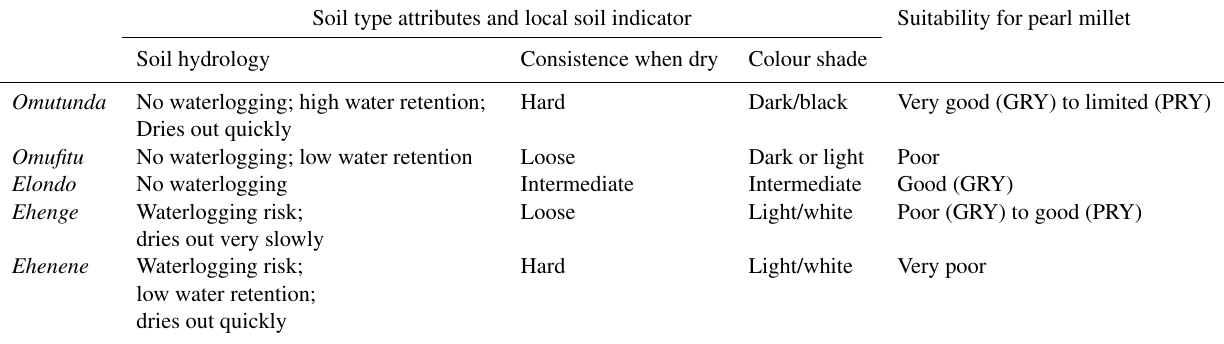
Table 4. List of the KwSUs identified and the most frequently used farmers’ field experiences characteristics. GRY, good rainfall year; PRY, poor rainfall